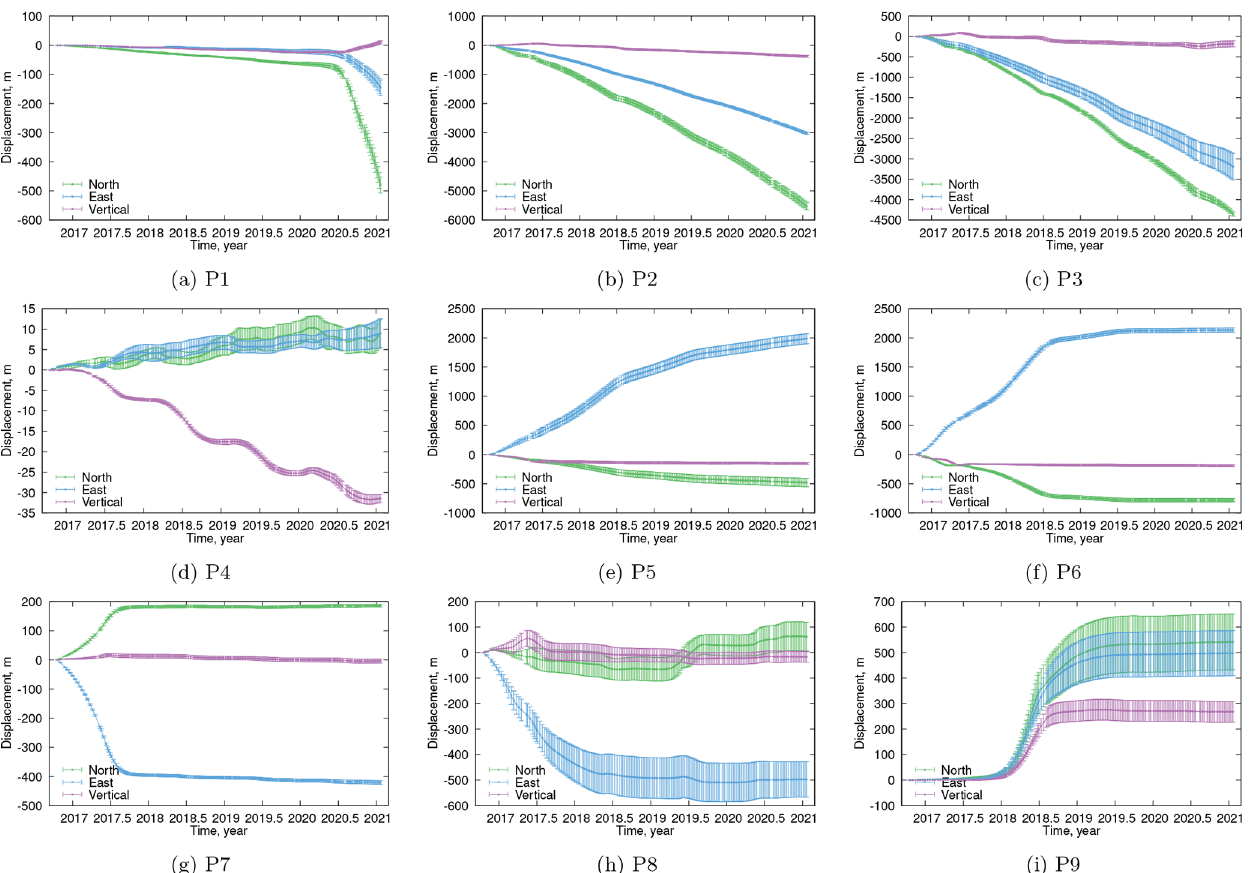
Figure 11. 3D flow displacement time series for regions P1–P9, the locations of which are shown in Figs.